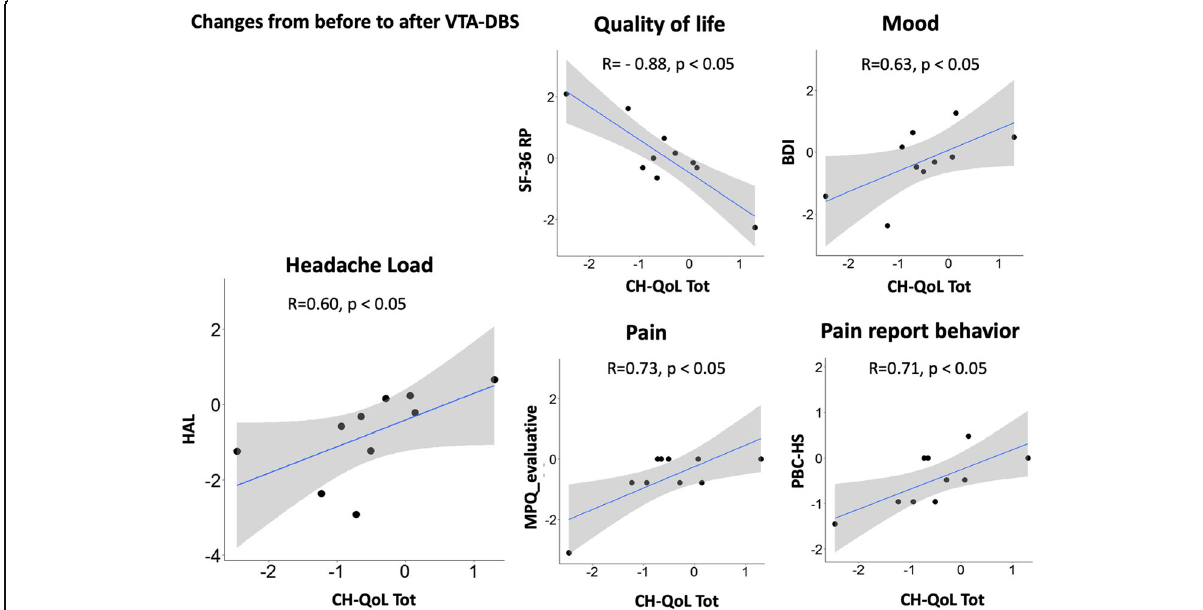
Fig. 2 Scatter plots representing significant Pearson correlations between changes in CH-QoL total score and changes in other measures of quality of life (SF-36), mood (BDI-II) and pain (McGill Pain Questionnaire evaluative scale, HIT-6) and Pain Behaviour Checklist help-seeking behaviours (PBC-HS) from before to after VTA-DBS. Note: CH-QoL total higher scores indicate poorer health related quality of life. SF-36 higher scores indicate better health related quality of life, BDI-II, HIT-6, McGill Pain Questionnaire (MPQ) lower scores indicate better functioning. BDI-II Beck depression inventory-II, HAL headache load, HIT-6 headache impact test-6, RP role physical, Tot CH-QoL total